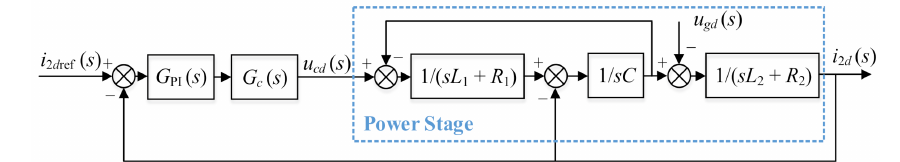
Figure 2. Block diagram of control loop for d-axis